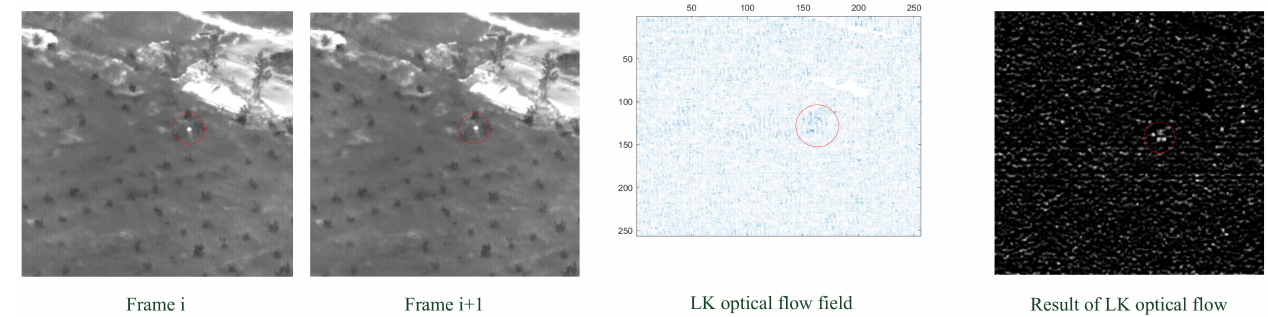
Figure 7. Infrared small moving target detection with the LK optical flow